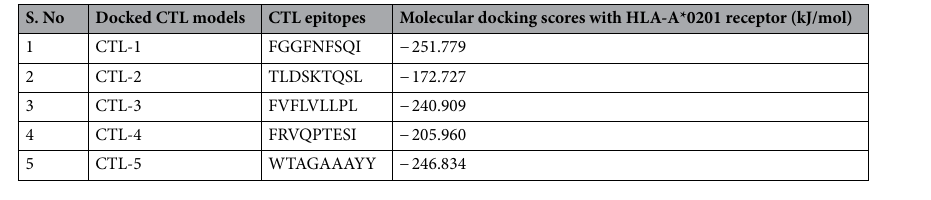
Table 3. Molecular binding analyses of shortlisted CTL epitopes with HLA-A*0201